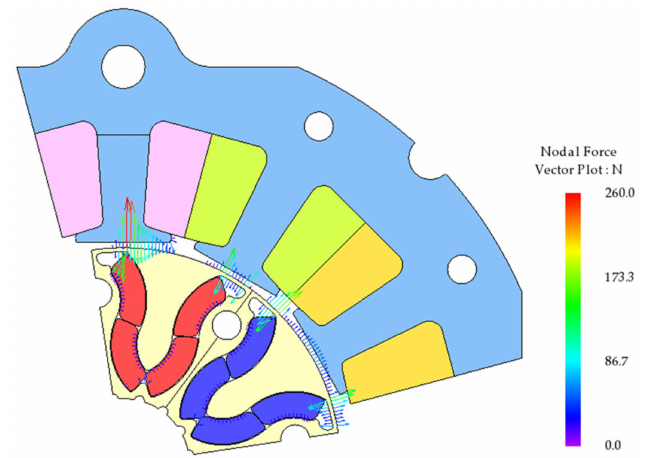
Figure 14. Nodal forces applied to stator teeth at the load condition.